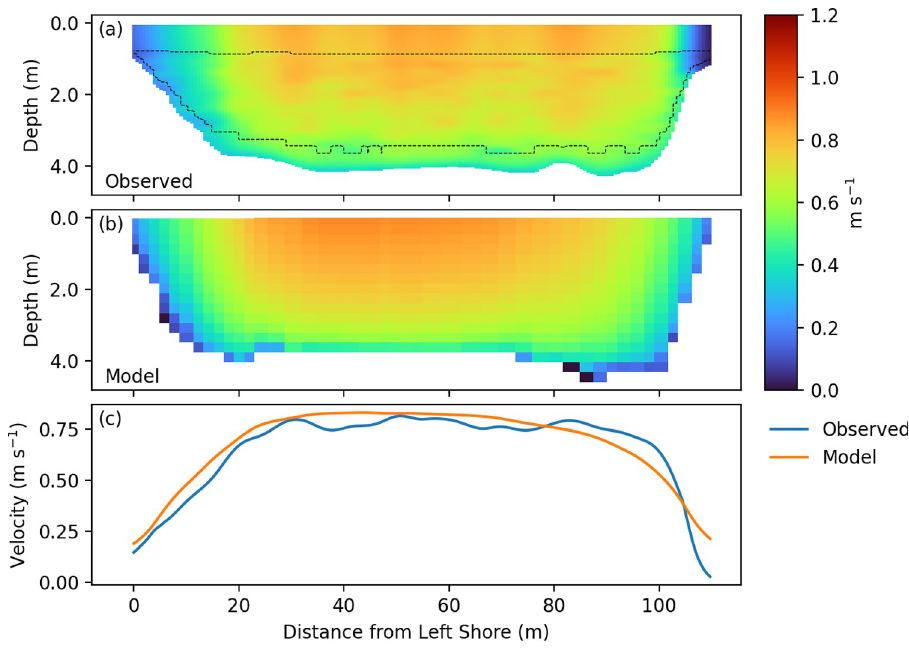
Fig 6. Model–data comparison for transect 5. Velocity comparison between ADCP observations (a) and model predictions (b) at transect 5. Velocity integrated over the top 2 m of the water column is plotted in (c). Dashed line in top panel denotes the extent of the original ADCP data before extrapolation. Field data has been smoothed with Hann filters of window size 9 in the vertical and 15 in the horizontal.